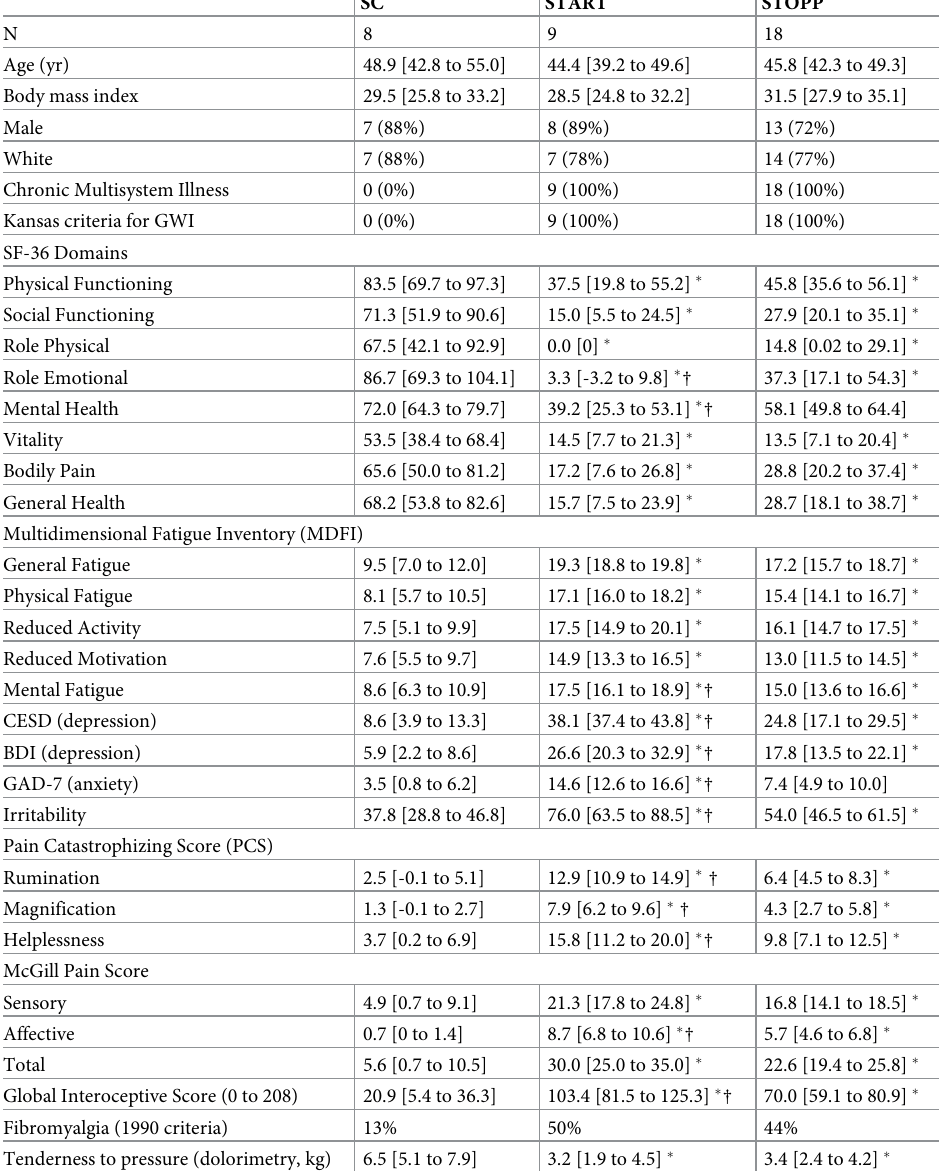
Table 2. Demographics and questionnaire scores for sedentary control (SC), and GWI START and STOPP